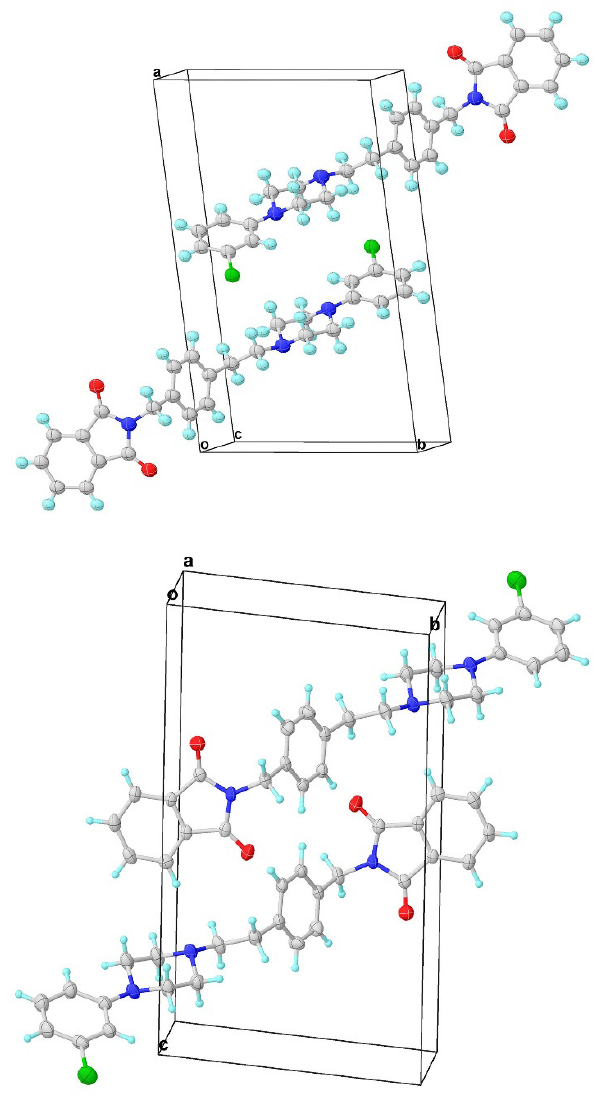
Figure 5: Displacement ellipsoid plot of the molecule determined by SXRD (a) and PXRD (b) with ellipsoids at the 30% probability level.